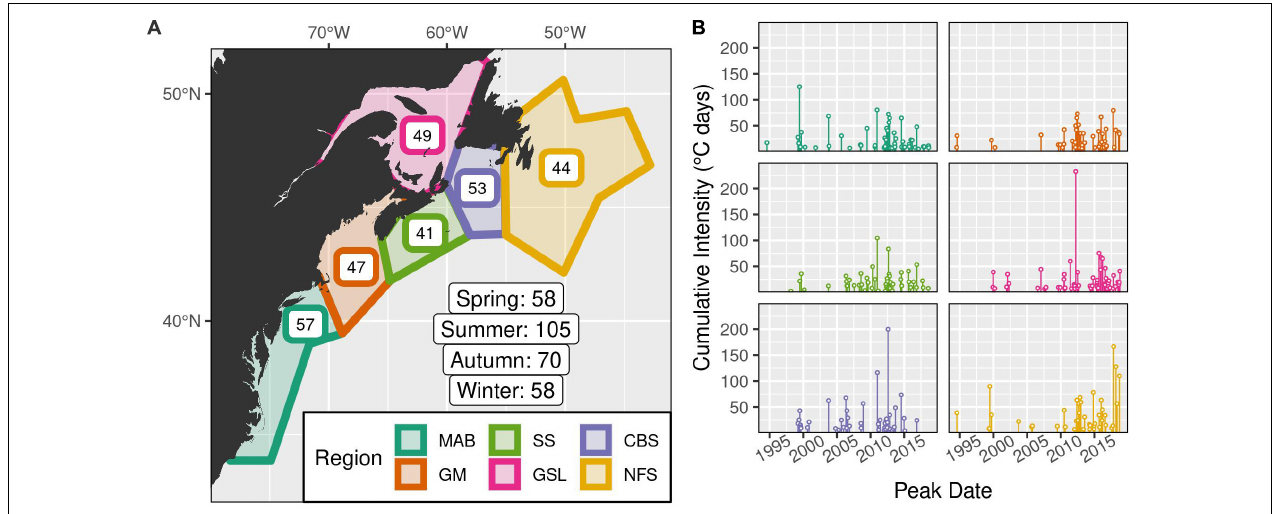
FIGURE 1 | (A) The coastal regions from Richaud et al. (2016) shown as colored polygons. The numbers within each polygon show the total count of marine heatwaves (MHWs) detected there during the 1993–2018 period. The total counts across all regions by season are shown with white labels above the legend. (B) Time series of the MHWs detected for each region from 1993 to 2018. The x -axis shows the peak date of occurrence of the events, and the y -axis shows their cumulative intensities ( ◦ C days). Note that while many of the MHWs appear clustered very close together, the median daily distance between events is 34 days, with a minimum of four, and a standard deviation of 314. The region abbreviations are: MAB, Mid-Atlantic Bight; GM, Gulf of Maine; SS, Scotian Shelf; GSL, Gulf of St. Lawrence; CBS, Cabot Strait; NFS, Newfoundland Shelf.